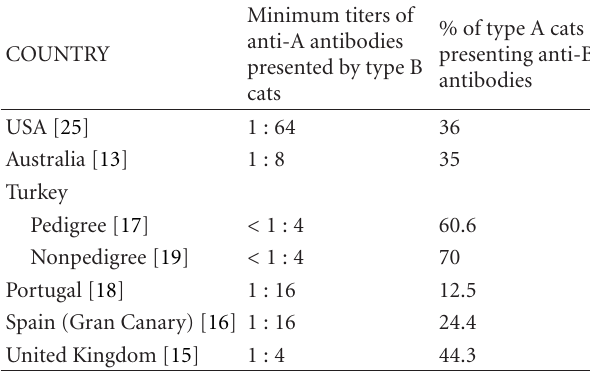
Table 1: Minimum anti-A antibodies titers presented by type B cats and percentage of type A cats presenting anti-B antibodies. In all studies, all type B cats presented anti-A antibodies titers. Anti-B antibodies in type A animals ranged from 1 : 2 to 1 : 16 in most